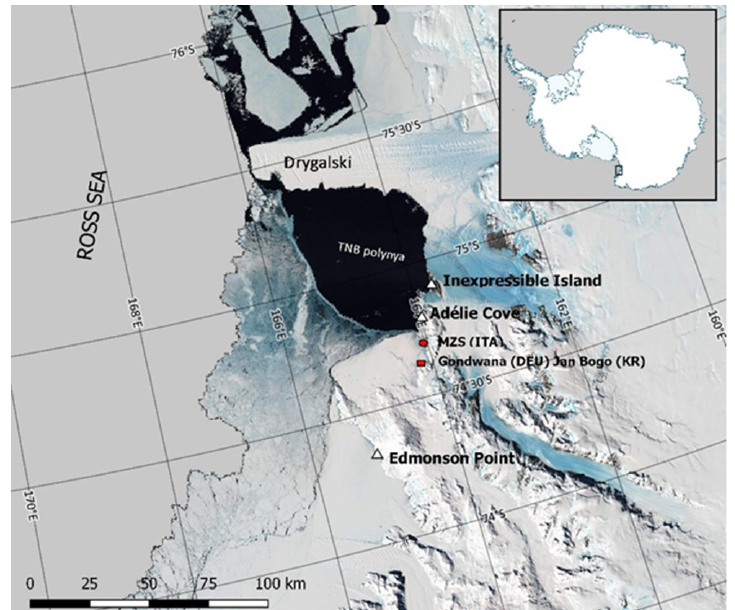
Figure 1. Map of the three study areas located in the Ross Sea (modified by [40]). Table 1. Ecological features of the three colonies located in central Victoria Land, Ross Sea, Antarctica. The linear distance to Terra Nova Bay polynya and range of fast ice extension was measured using EOSDIS Worldview [42] to the best image available in late October, mid-December, and mid-January from 2017 to 2019. The approximate size of the colony area was measured with Google Earth Pro on images on the 23 February 2010, 27 November 2011 and 2 December 2011 for Edmonson Point, Adélie Cove, and Inexpressible Island, respectively, updated from [40]. N. of